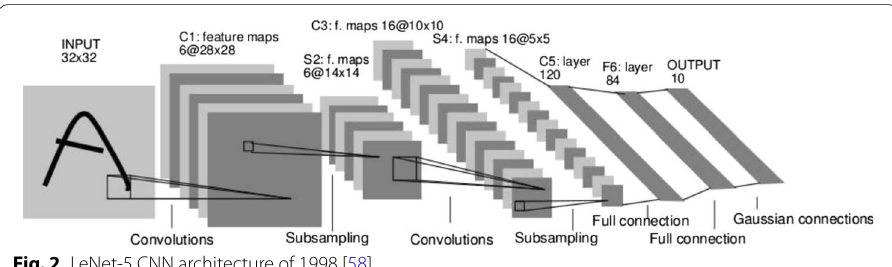
Fig. 2 LeNet-5 CNN architecture of 1998